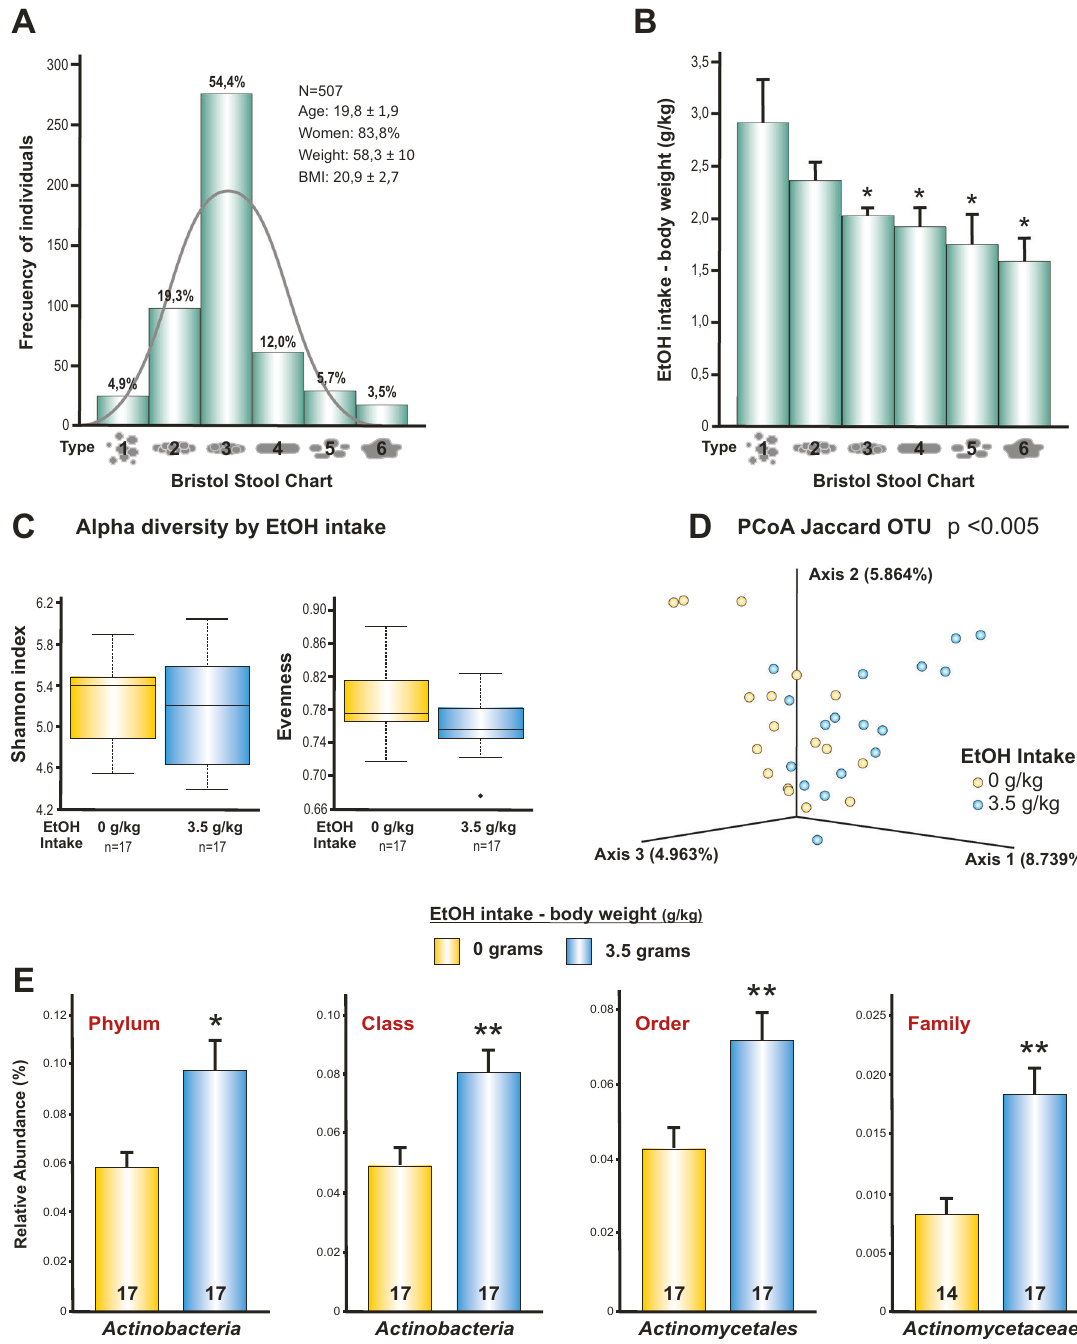
Fig. 1 Association between stool type, alcohol consumption and IMB in human participants. A Distribution of the stool samples of university students according to the Bristol Stool Scale. B Association between heavy episodic drinking (g/kg BW) and stool type. * p < 0.05 compared to stool type number 1 ( n = 507). C Alpha diversity did not differ signi fi cantly between groups. D Beta diversity showed signi fi cant differences between the groups (Jaccard distance index, p < 0.005). E Signi fi cant changes in the relative abundance of IMB. Actinobacteria was the main taxa affected by alcohol consumption. * p < 0.05; ** p < 0.01 compared to non-alcohol group. B , E graphs represent mean ± s.e.m. Source data are provided as a Source Data fi